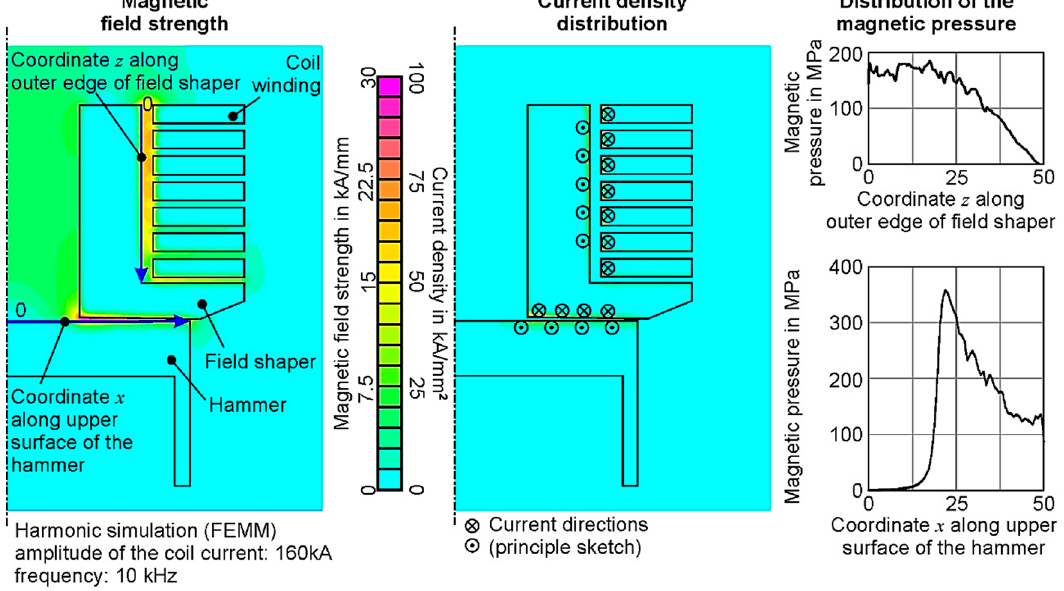
Figure 8. Magnetic field strength, current density, and magnetic pressure in the electromagnetically driven acceleration unit.